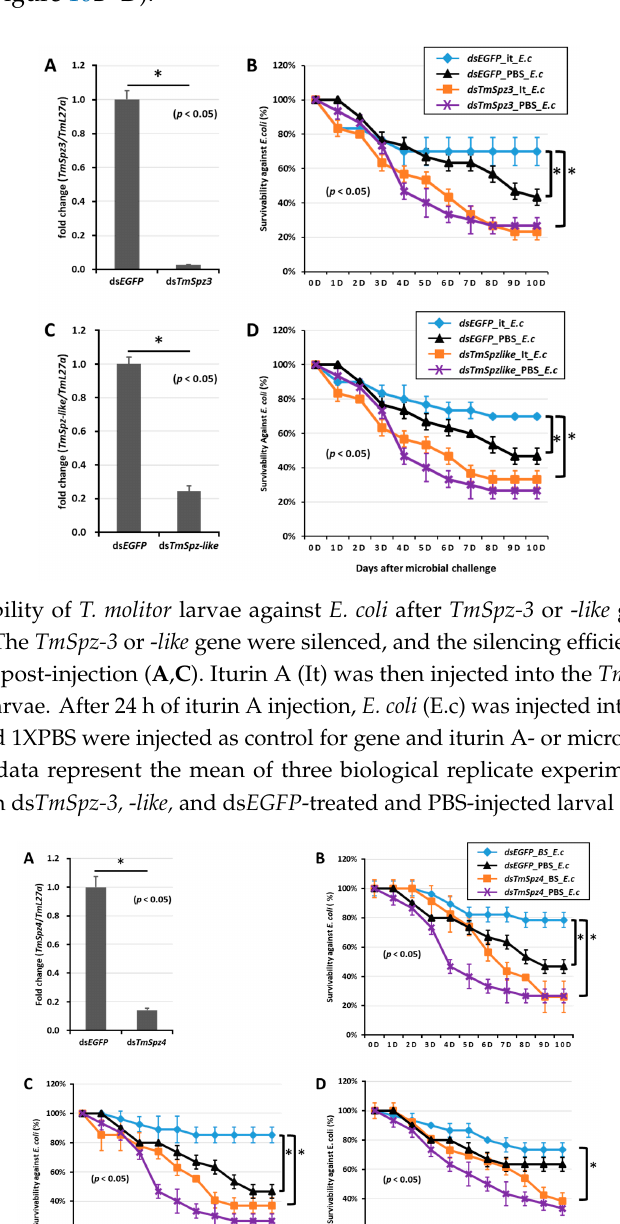
Figure 10. Survivability of T. molitor larvae against E. coli (E.c) after TmSpz6 gene silencing and biosurfactant injection. The TmSpz6 gene was silenced, and the silencing efficiency of TmSpz6 mRNA was measured by qRT-PCR at 3 d post-injection ( A ). Then, biosurfactants (BS) including fengycin ( B ), iturin A ( C ), and rhamnolipid ( D ) were separately injected into gene-silenced larvae. E. coli was then